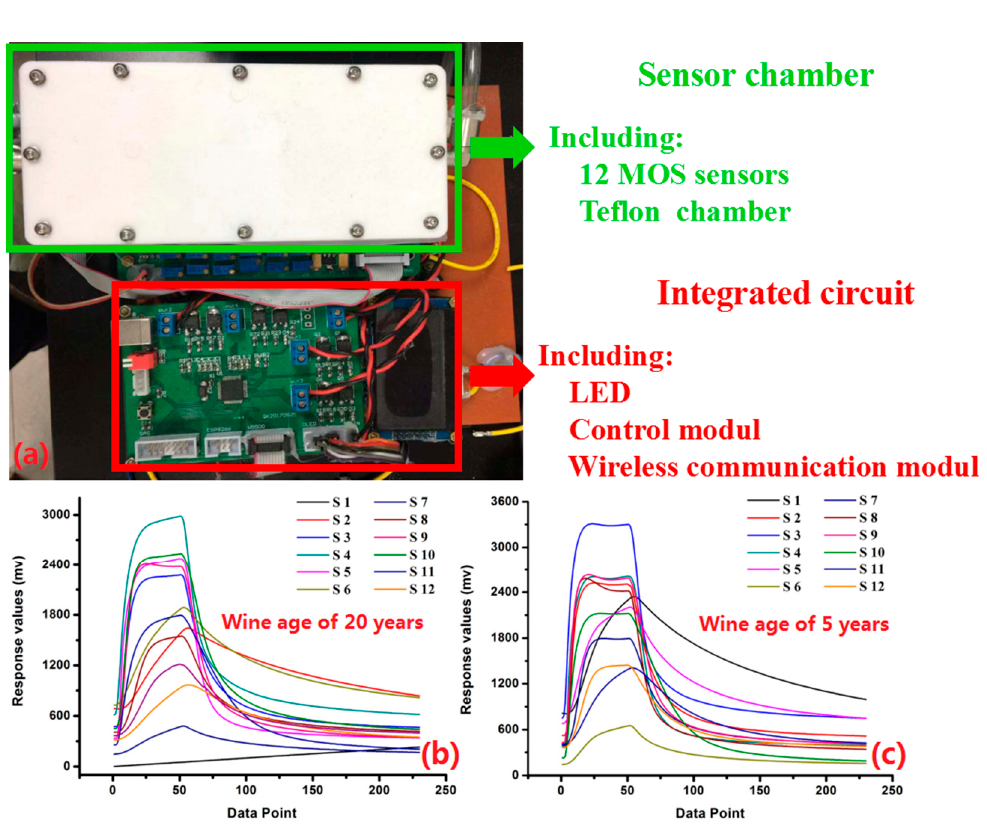
Figure 2. The set-up of the portable electronic nose ( a ) and the typical responses of 20-year ( b ) and 5-year ( c ) samples. 5-year ( c )